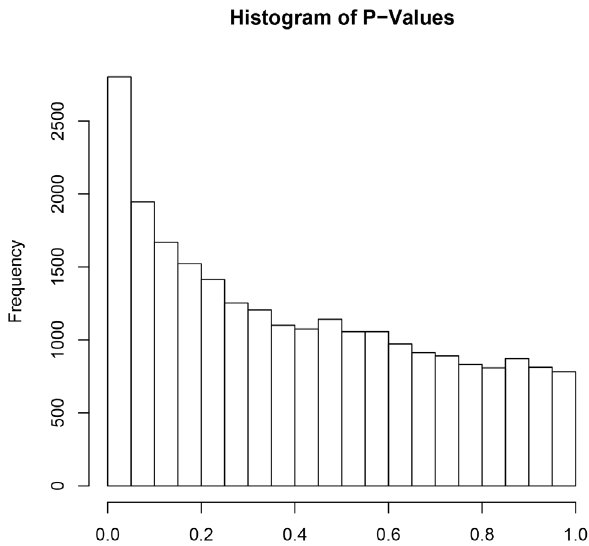
Figure 2. Histogram of P -Values. Using the ANOVA analysis, a histogram of P-values was generated based on the treatment effects for genes present in at least one array (18,603 genes). It is observed a higher than expected (under the null hypothesis of no treatment effects) number of genes with low P -Values.